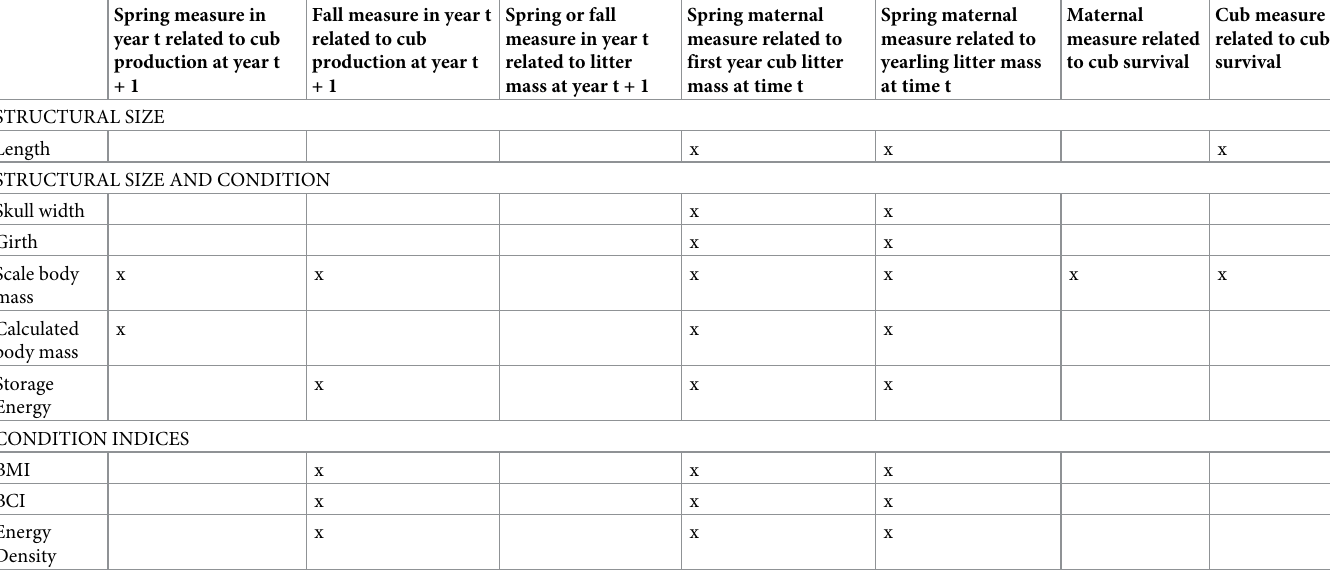
“x” indicates that the size or condition measure had a 95% confidence interval on β -value that did not overlap 0 and a p-value �